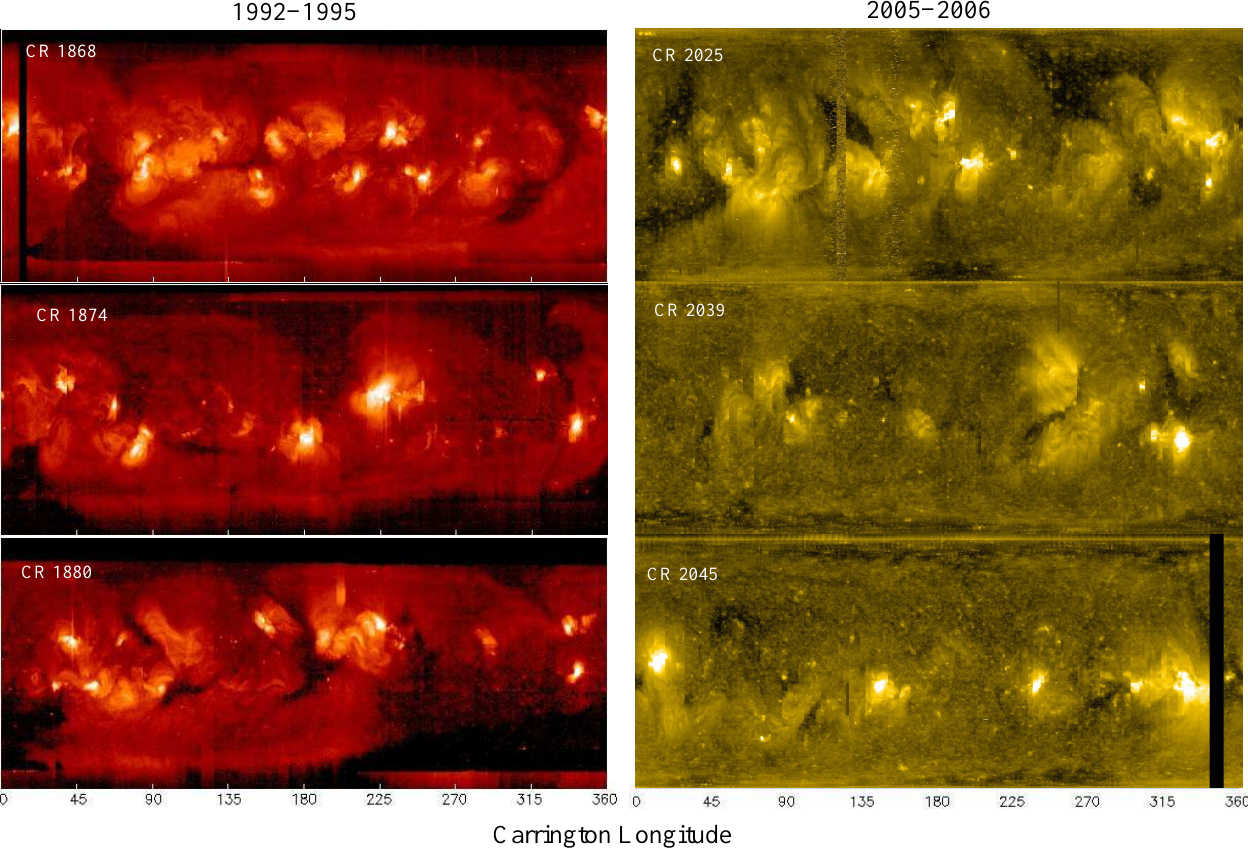
Fig. 12. Left panel: Yohkoh SXT Carrington maps for rotations number 1868, 1874, and 1880, standing for the periods C22/P1, the transition and C22/P2. Right panel: SOHO EIT Carrington maps at 284 ˚A for rotations number 2025, 2039, and 2045, resprenting the time intervals C23/P1, the transition and